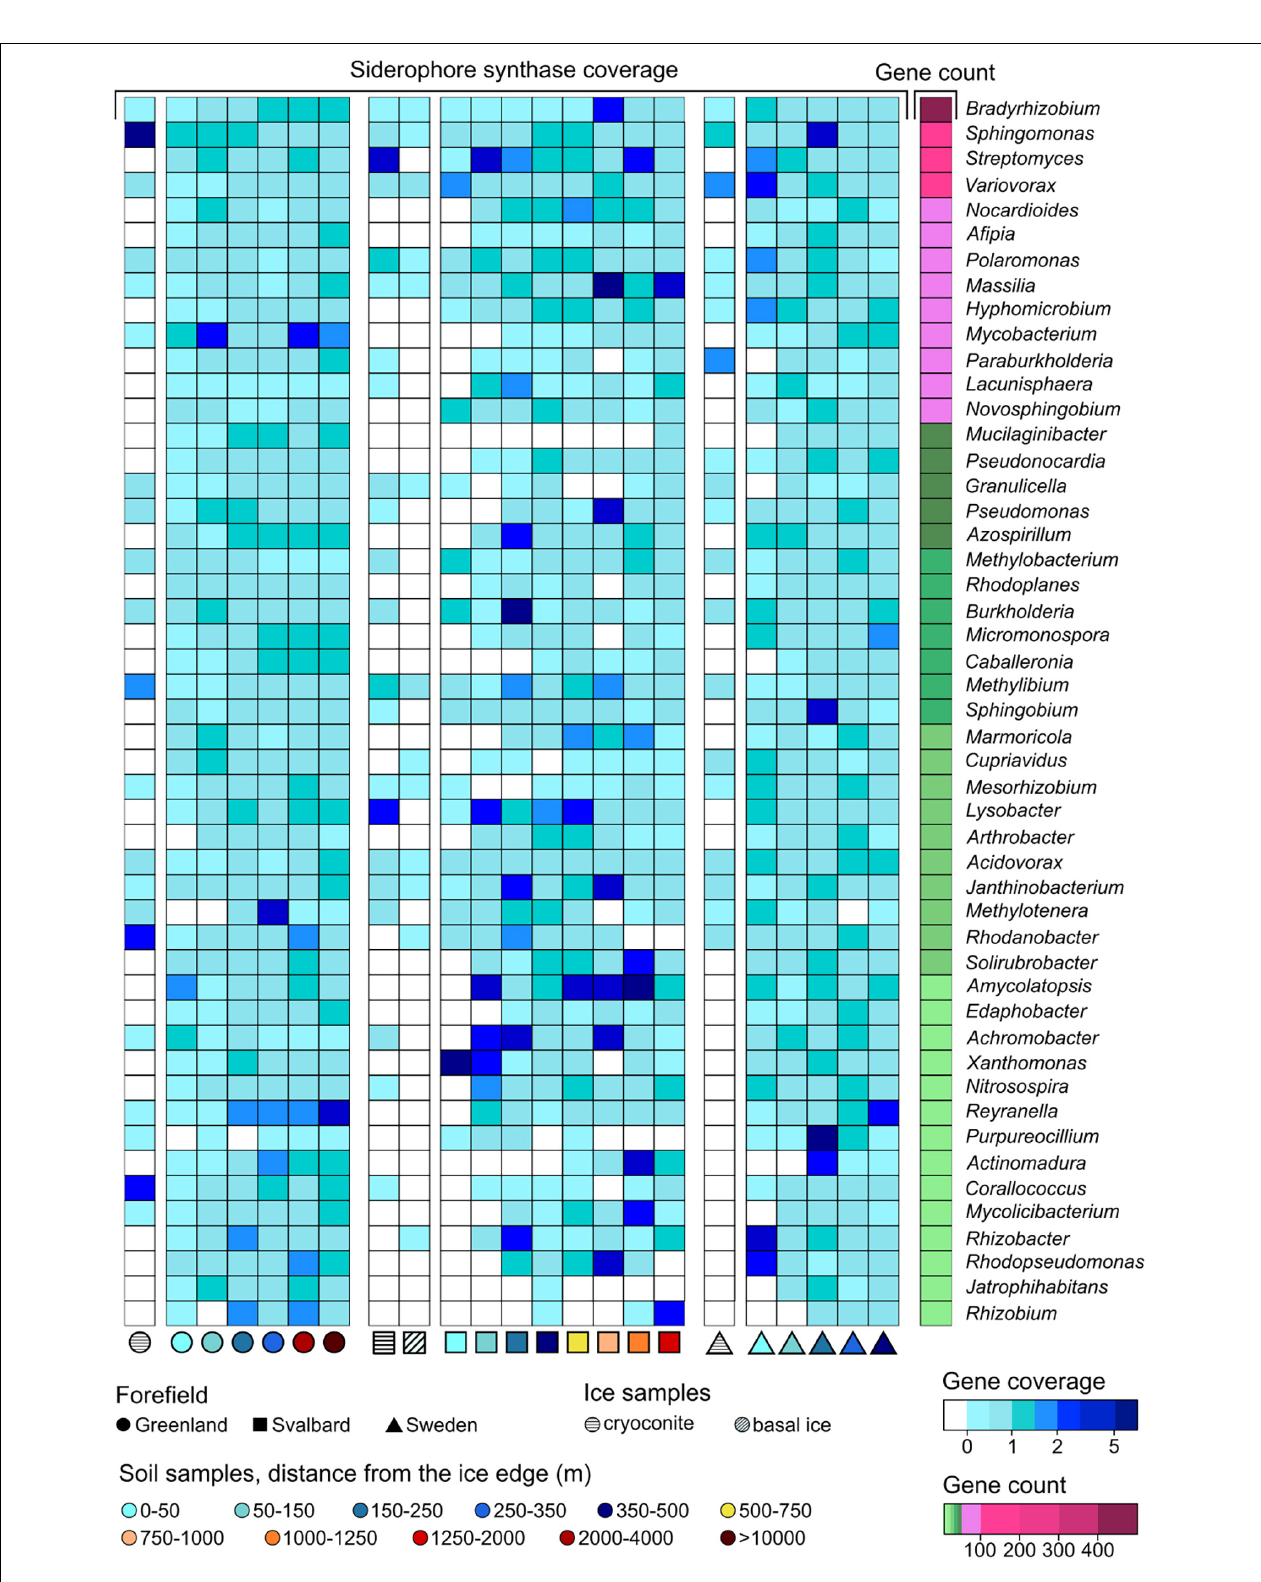
FIGURE 9 | Siderophore-related gene trends at the genus level along the microbial successions. Only genera with more than 10 coding regions associated with siderophore-related genes are reported.